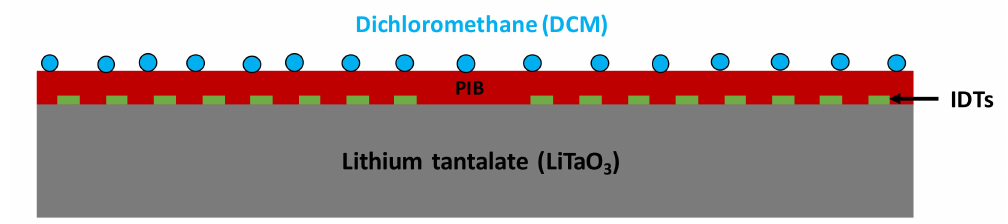
Figure 7. Schematic representation of a SAW device functionalized with a PCB layer for DCM recognition.